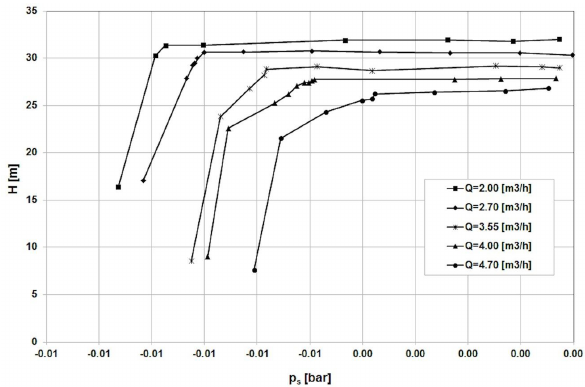
Figure 11: Characteristics of the Impeller 3